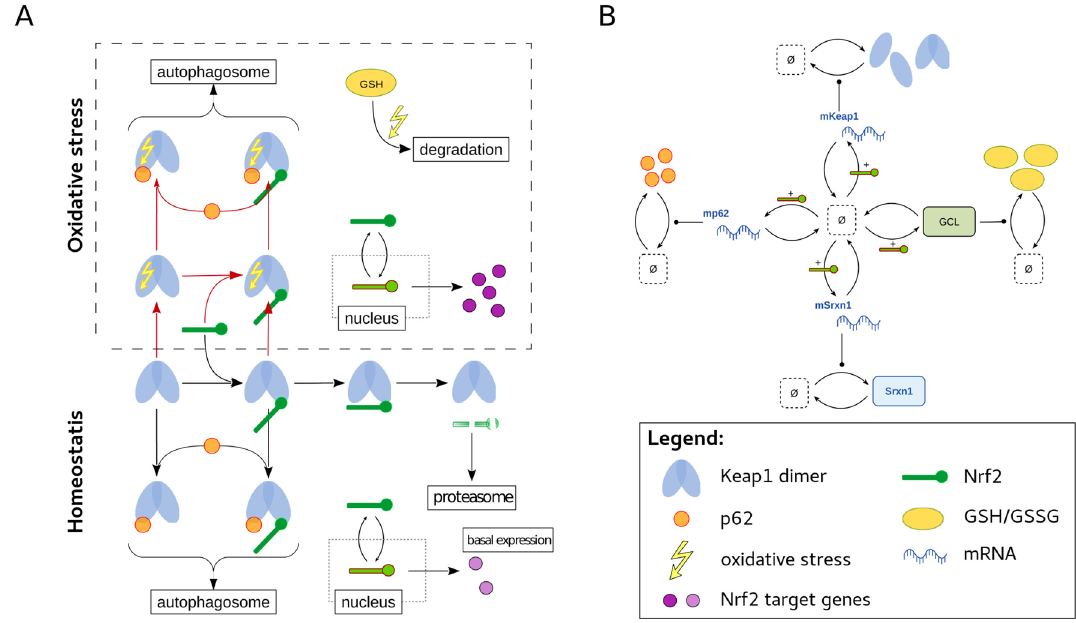
Figure 1. Pathway scheme. ( A ) Homodimers of Keap1 (shown in blue) are able to bind the ETGE (high affinity or hinge binding) and the DLG (low affinity or latch binding) motifs of Nrf2 (shown in green). When both Nrf2 motifs are bound, Keap1 can target Nrf2 for proteasomal degradation. p62 (shown in orange) is able to compete with Nrf2 for its latch binding to Keap1, resulting in autophagosomal degradation of Keap1. Upon oxidative stress (yellow arrow), Keap1 is no longer able to target Nrf2 for proteasomal degradation by lack of binding of the DLG motif. This results in nuclear accumulation of Nrf2 and target gene transcription including SRXN1, NQO1, HMOX1 and GLCM (shown in purple). In addition, oxidative stress is reduced via GSH (shown in yellow). ( B ) Scheme explaining the considered target gene expression of Nrf2 upon oxidative stress. Reactions between the constituents are represented by arrows. They are translated into differential equations for the quantitative model.